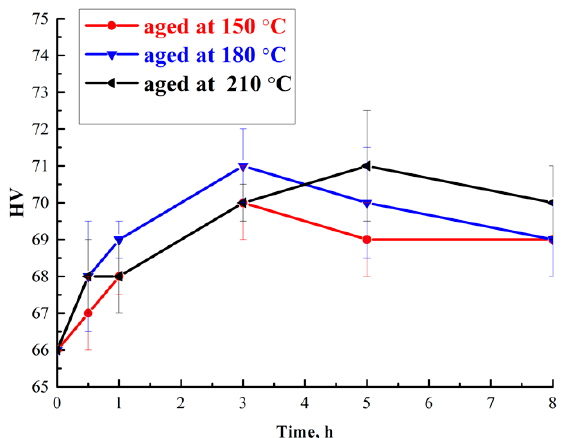
Figure 2. Microstructure of the annealed alloy at 605 °C for ( a ) 1 h and ( b ) 3 h, and the distribution of alloying elements inside the white square on the SEM microstructure.